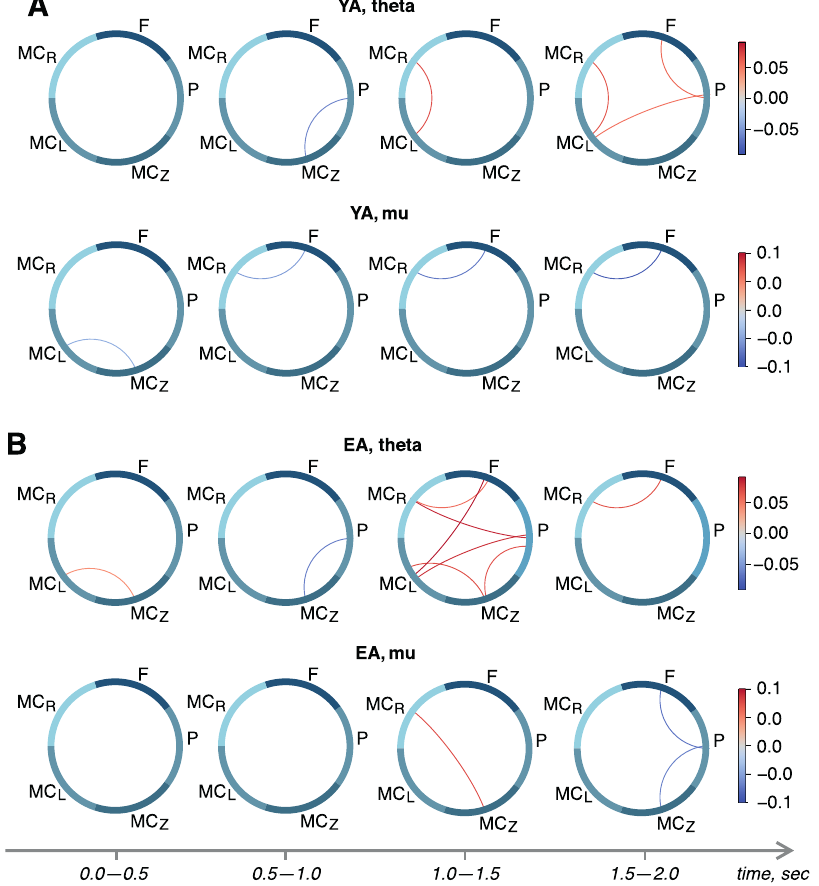
Figure 3. Within-subject differences between the R 2 -score matrices in different time frames of stimulus-related activity for young adults ( A ) and elderly adults ( B ). Upper and lower rows in each subplot show connectivity in theta- and mu-bands,